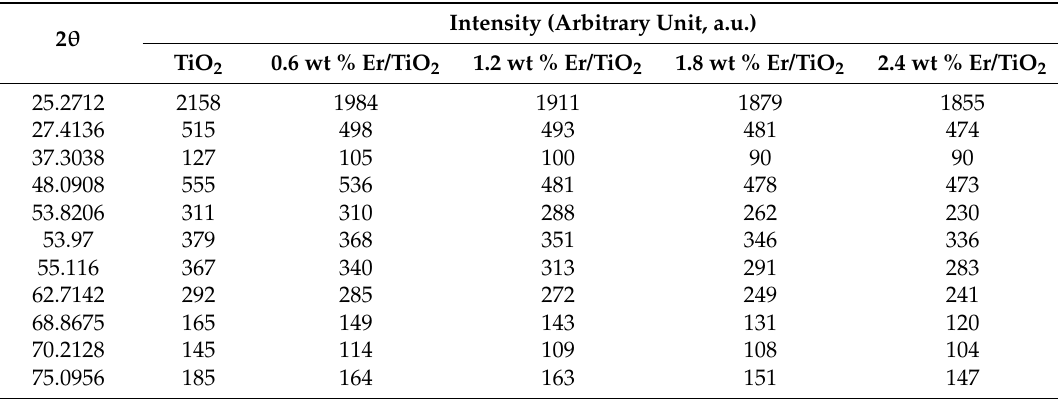
Table 1. Intensity of all peaks of TiO 2 and Er/TiO 2 .